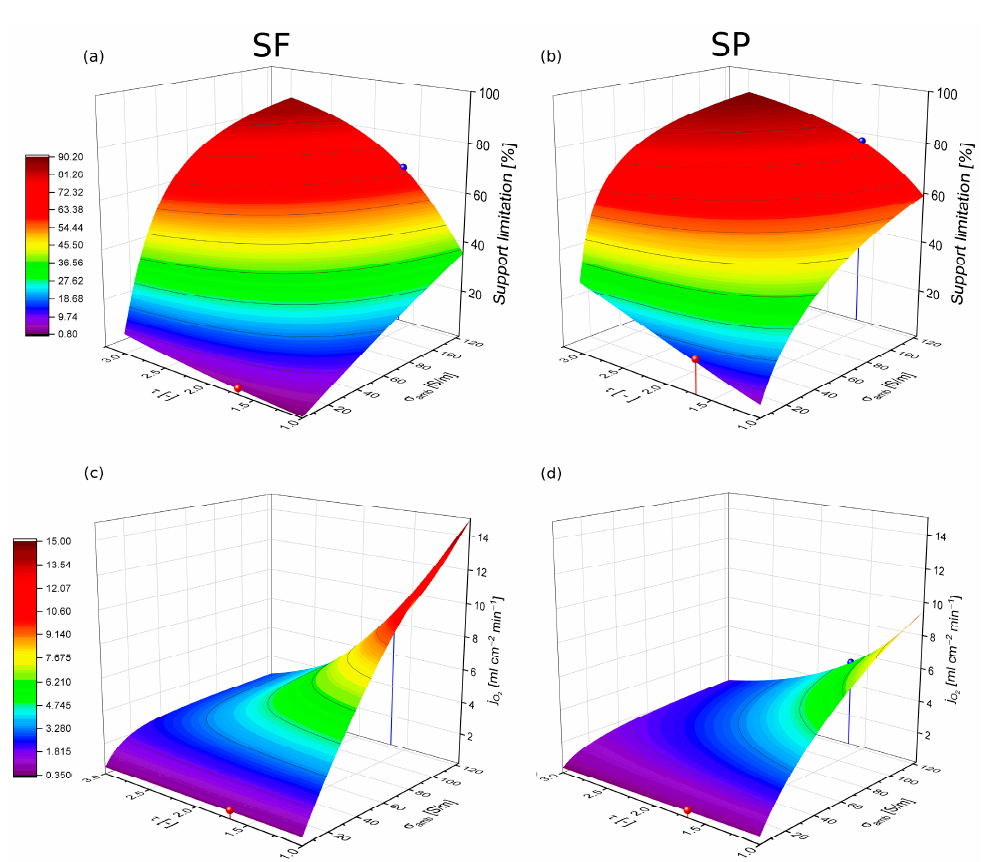
Figure 6. Influence of tortuosity and ambipolar conductivity on the support limitation ( a , b ) and the flux ( c , d ). The red and the blue dots represent the parameter sets investigated in the sensitivity analysis.